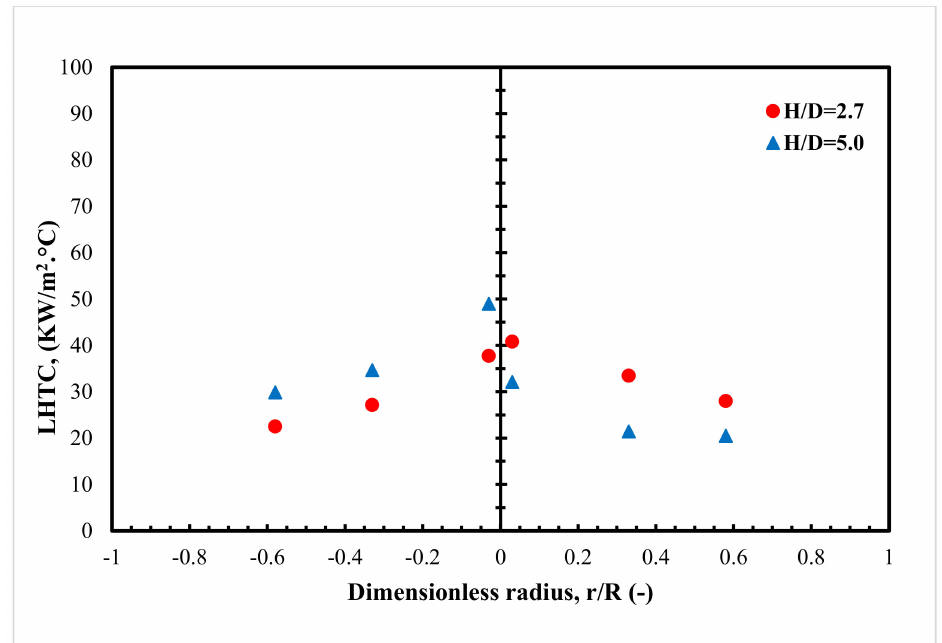
Figure 15. LHTC profiles measured at the different axial levels of 35 and 70 cm and under an operating gas velocity of 0.35